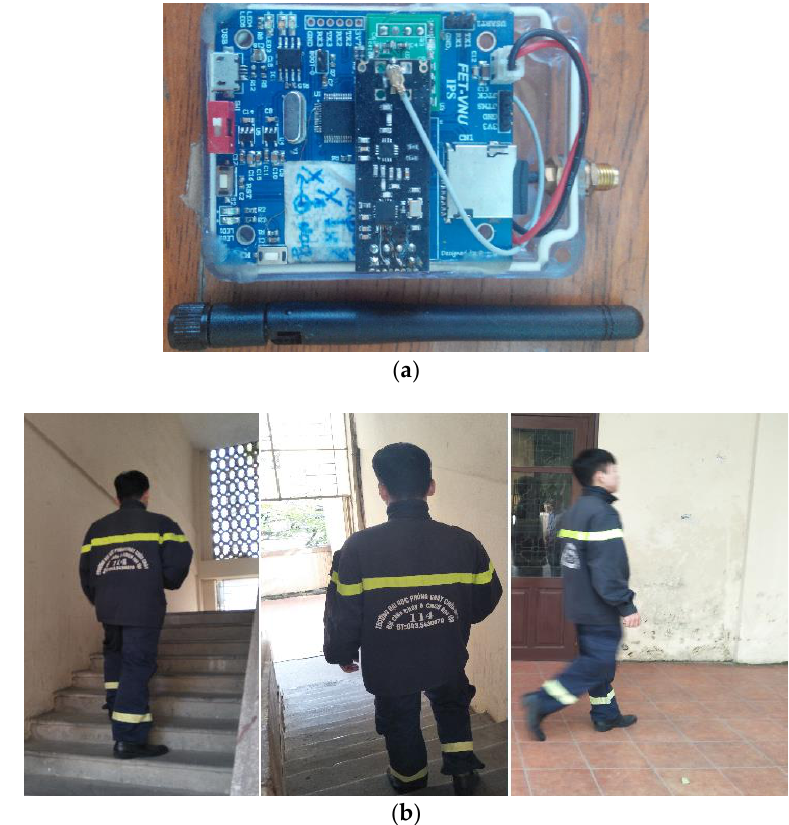
Figure 9. Our proposed system and a volunteer recording data: ( a ) Our proposed system; and ( b ) A volunteer is recording data.